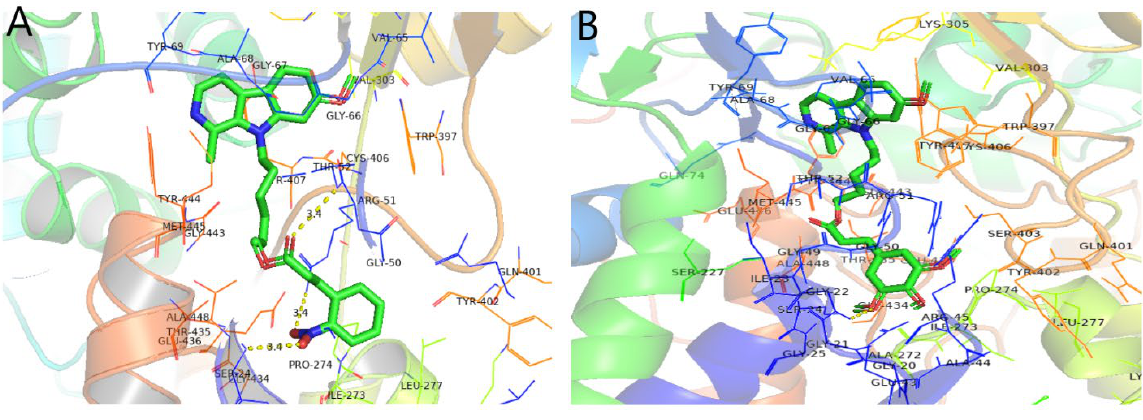
Figure 5. Schematic diagram of target compound 7l ( A ) and 7h ( B ) binding to Amine oxidase [flavin- containing] A protein.